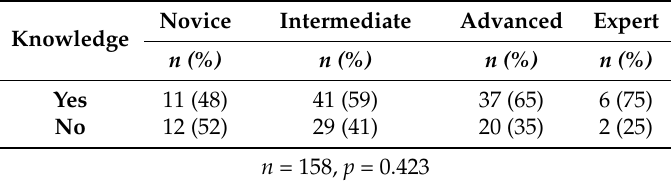
Table 8. Detection accuracy by knowledge level (syn attack).